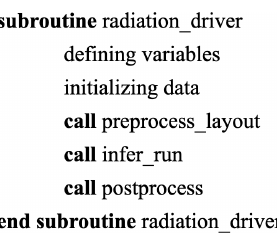
Figure 2. Pseudo-code for the ML-based RRTMG